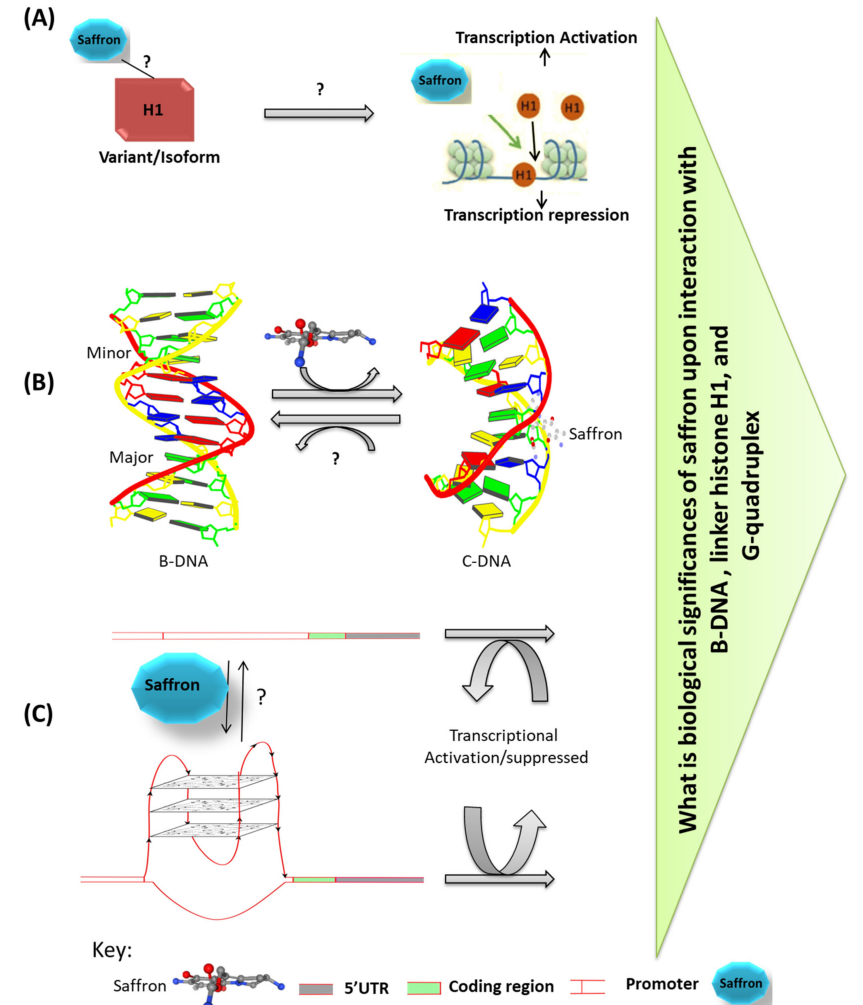
Figure 1. Interplay of saffron with different biomolecules. ( A ) Interaction of saffron with linker histone H1. ( B ) Saffron binds to double-stranded B-DNA minor groove and converts to C-DNA conformations. ( C ) Saffron binds and stabilizes the G-quadruples structure of DNA. The biological consequences of the interplay of saffron with H1, B-DNA, and G-quadruples have not been studied, A–blue, C–yellow, G–green,